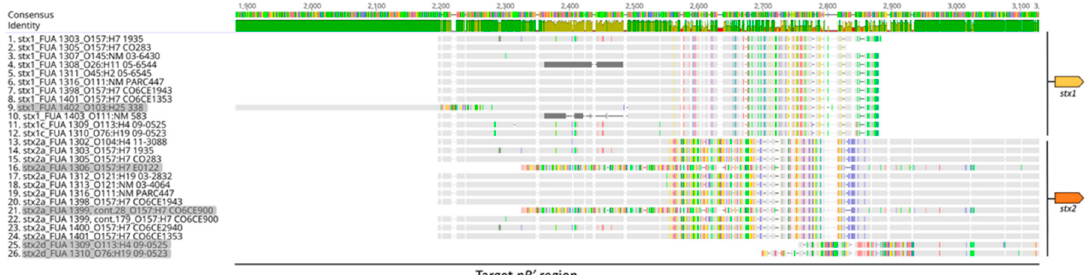
Figure 3. The sequence comparison of the p R’ regions. The toxin subtypes and the name of their host strains are listed on the left. Consensus is shown on top. Sequence identities are colored in green, yellow, and red, which indicate that the residue at that position is the same across all sequences, less than complete identity and very low identity, respectively. The schematic s tx genes were annotated behind the p R’ regions. The sequences that did not have the same p R’ site as the reference are shaded. The figure is provided in high resolution for large scale printing or viewing.